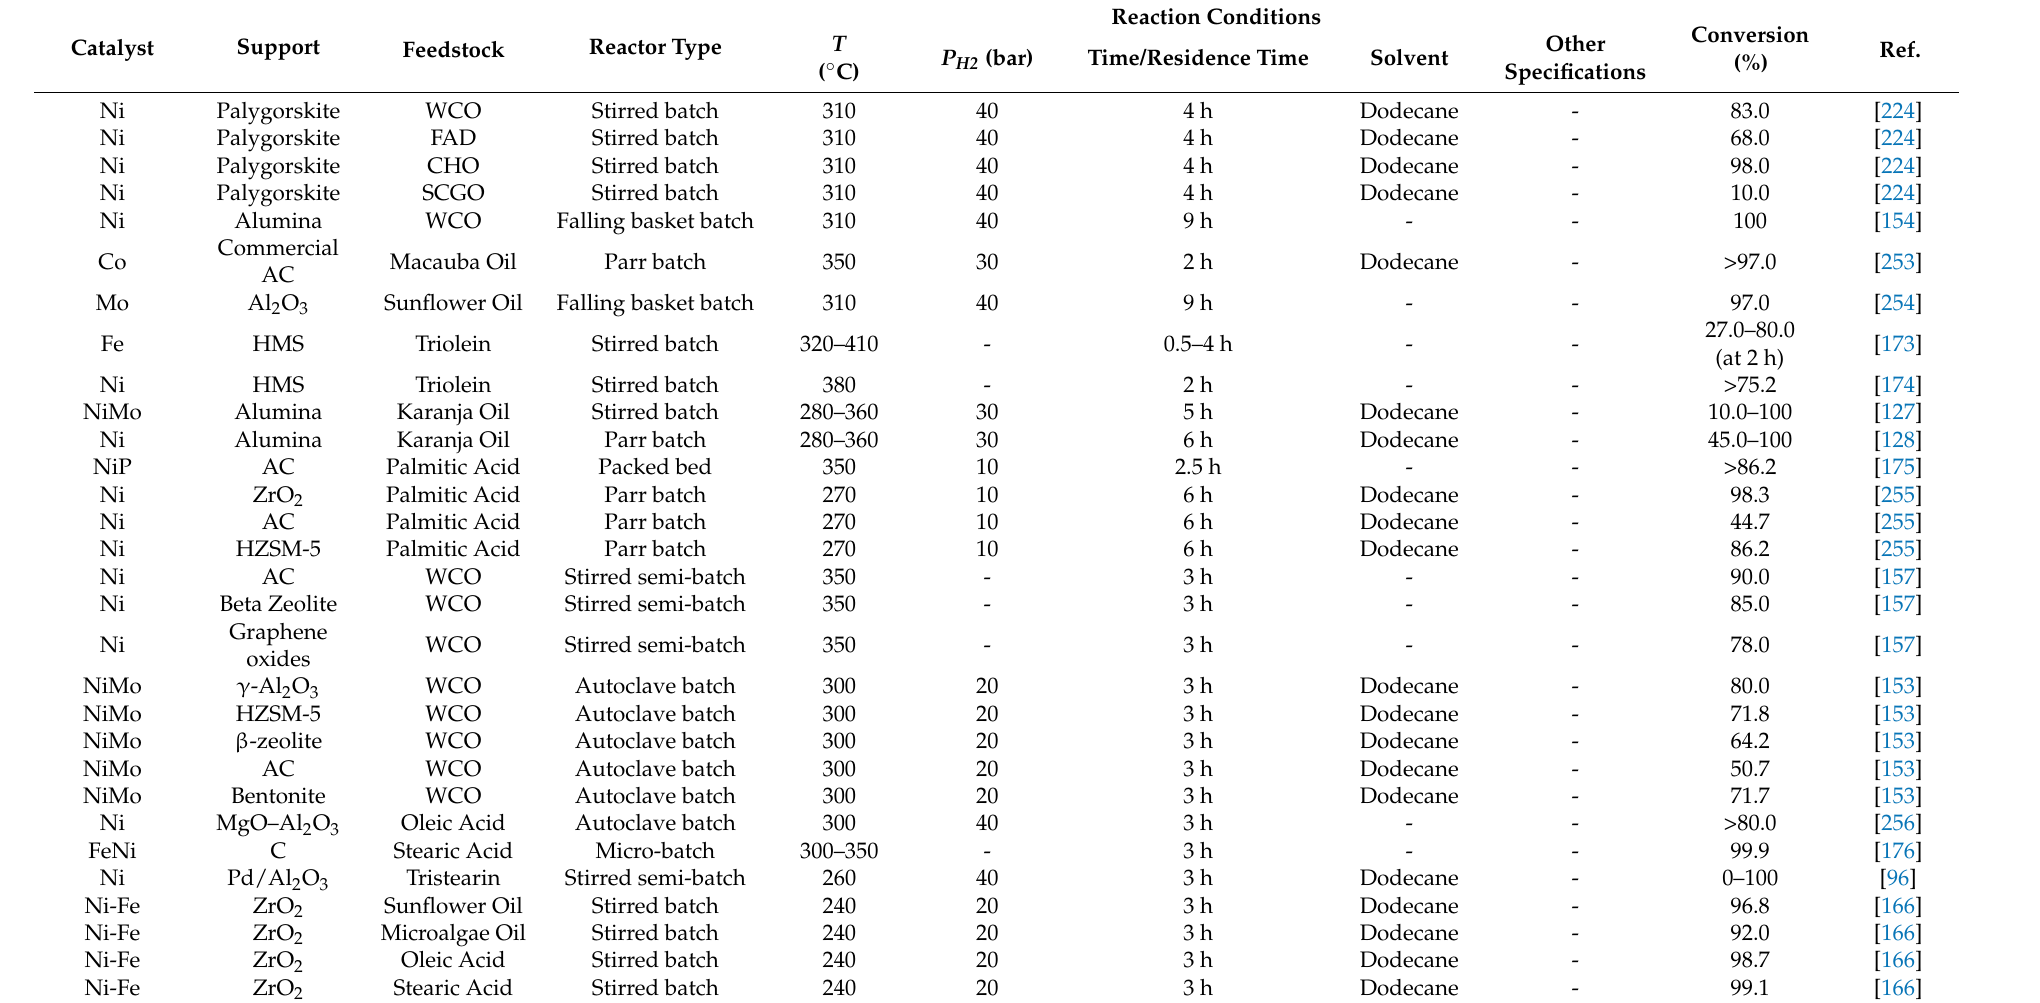
Table 5. Summary of catalytic studies in batch, semi-batch, and continuous